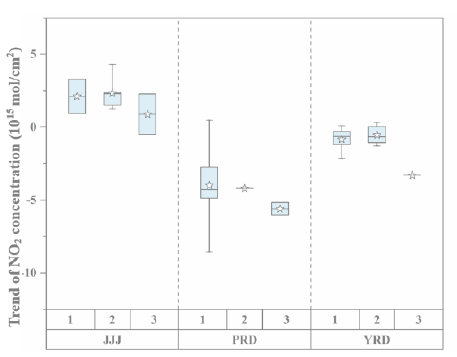
Figure 4. The trend of NO2 concentration during 2005–2016 in cities of different urbanization